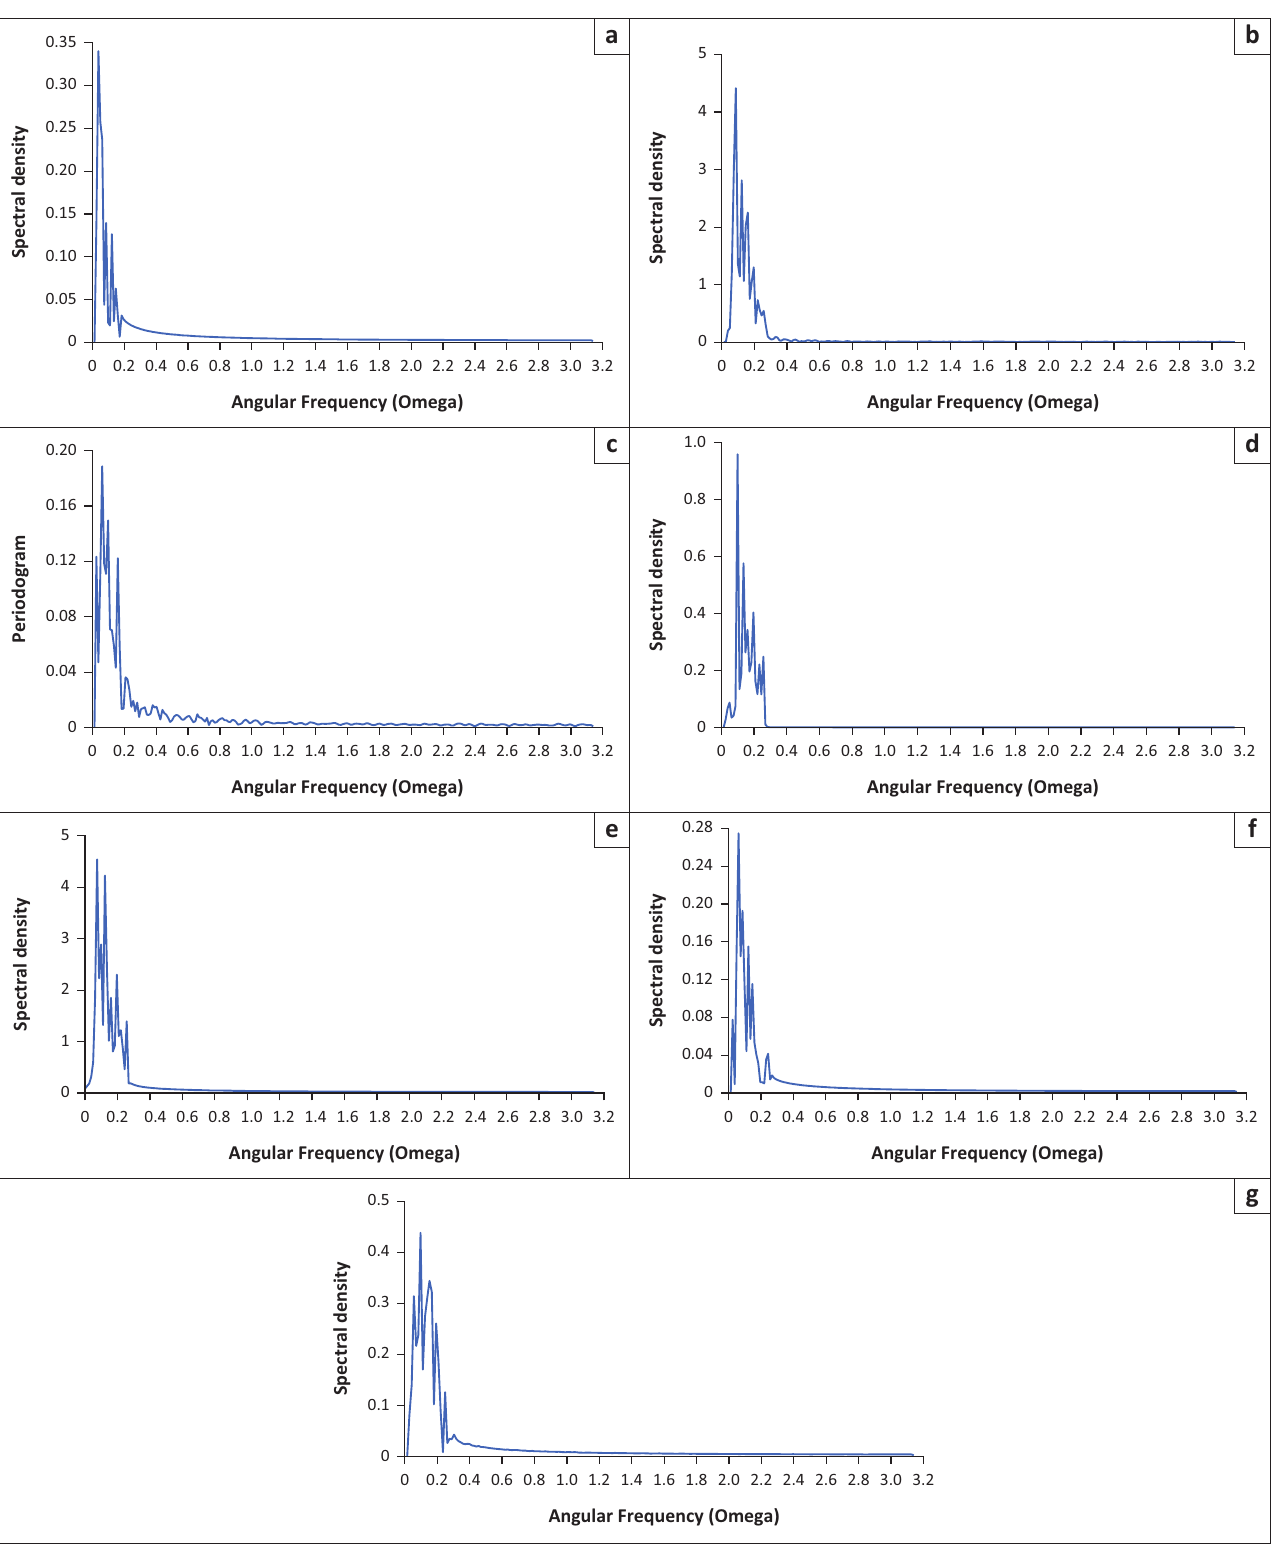
FIGURE 4: Spectral density plots for each South African financial cycles. (a) credit cycle, (b) interest rate cycle, (c) house price cycle, (d) equity cycle, (e) confidence cycle, (f) bank balance sheet cycle, (g) foreign financial position